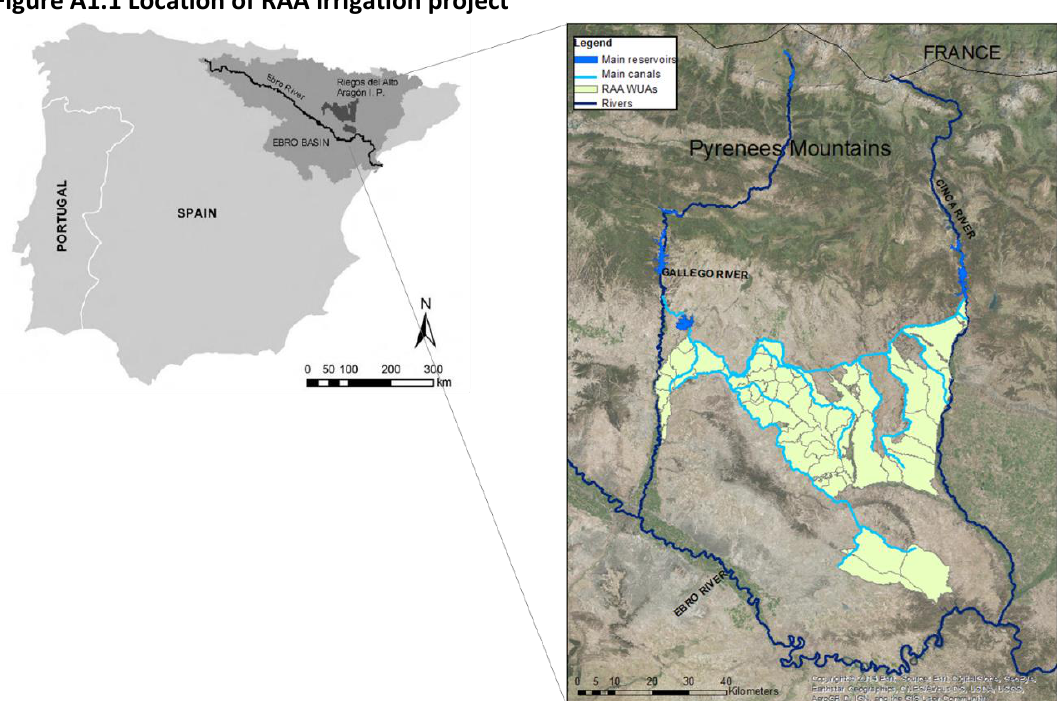
Figure A1.1 Location of RAA irrigation project